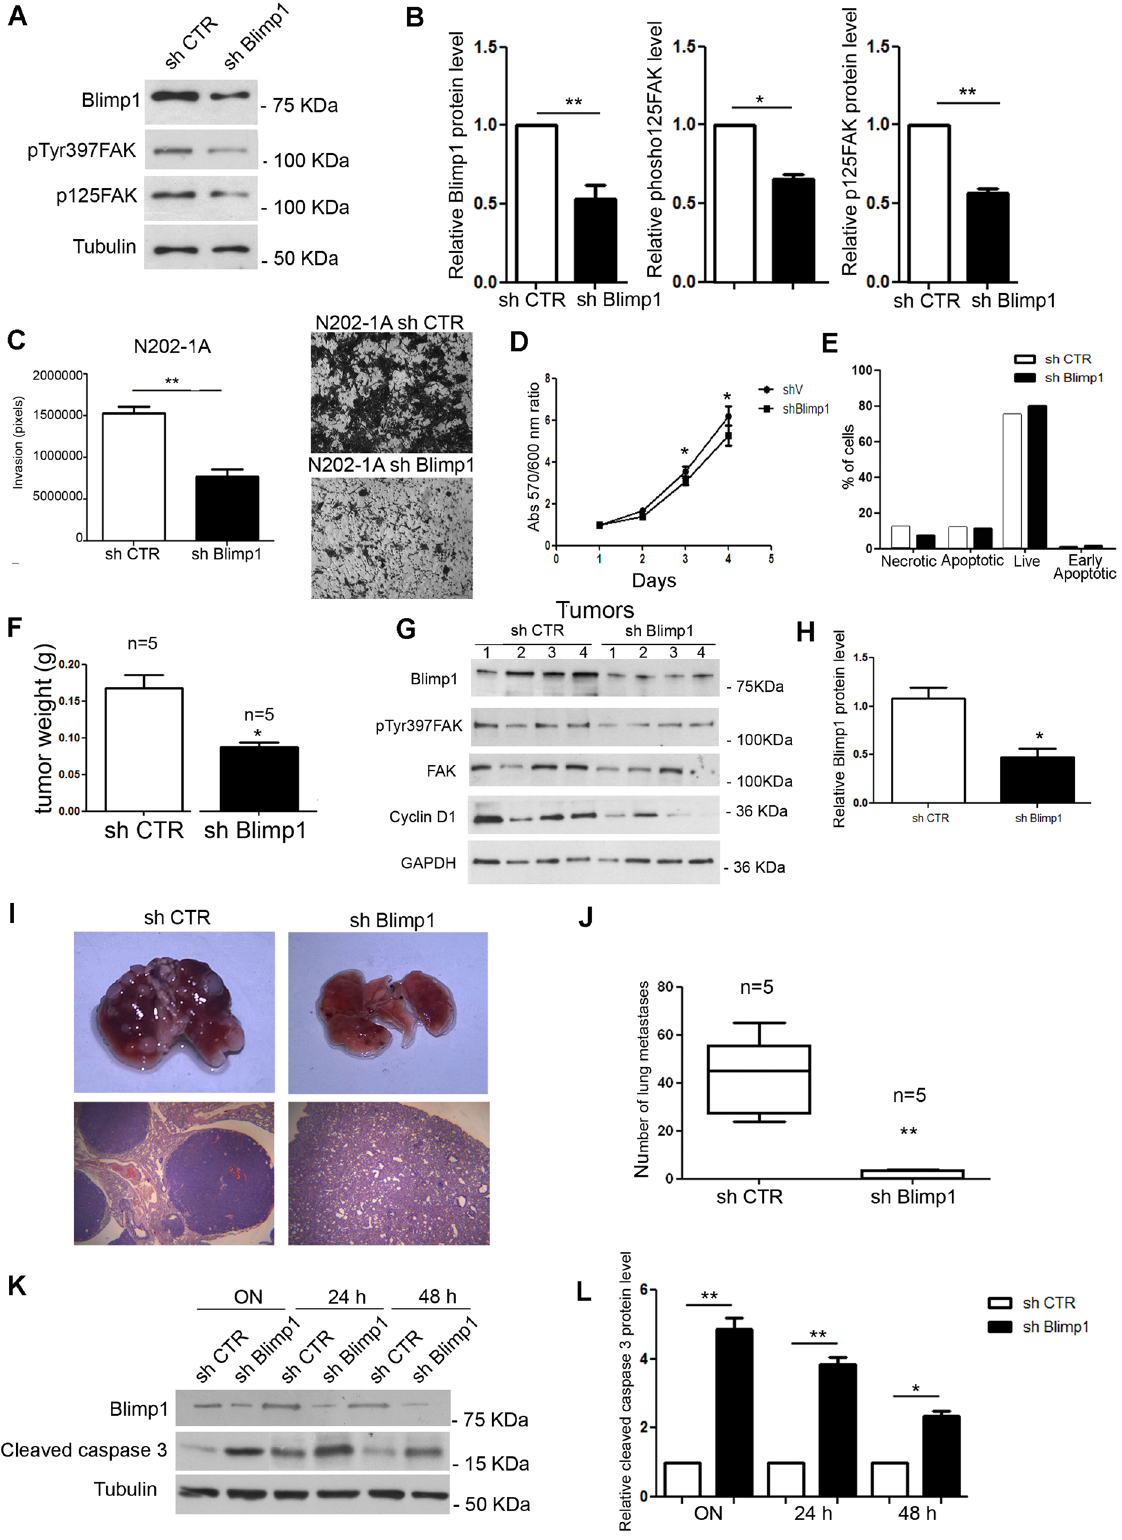
Figure 4. Blimp1 silencing impairs cell motility and in vivo metastasization of N202-1A cells. ( A ) N202-1A cells were transduced with a mouse shRNA sequence for Blimp1 and total cell extracts were probed for Blimp1, phospho-FAK(Tyr397) and p125FAK in a western blot analysis. Tubulin was used as the loading control. ( B ) Densitometric analyses of Blimp1, phospho-FAK(Tyr397) and FAK protein levels in at least three independent experiments are shown (mean ± s.e.m). Protein modulation was calculated relative to control cells and normalized on tubulin as loading control. Statistical analyses were performed using the Student’s